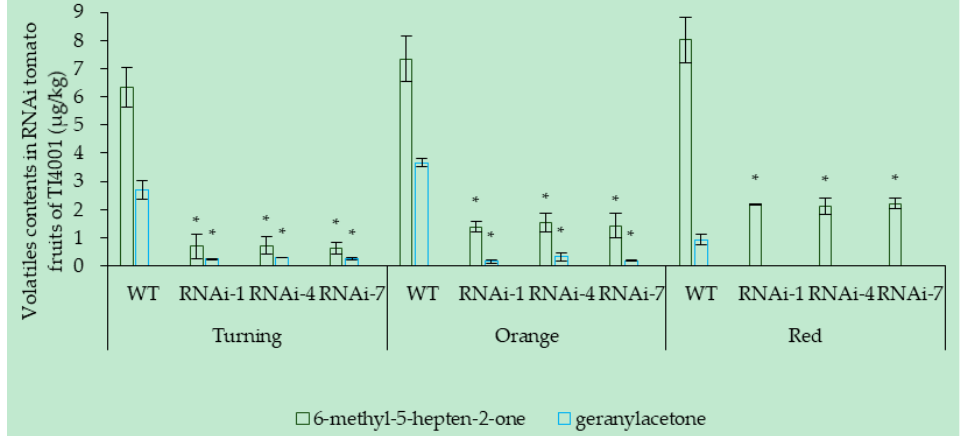
Figure 11. RNAi of SlCCD1A on the contents of the carotenoid-derived volatiles in TI4001 tomato fruits (µg/kg). * indicates that the content of 6-methyl-5-heptene-2-one or geranylacetone was significantly lower in RNAi lines than in WT ( p < 0.05).